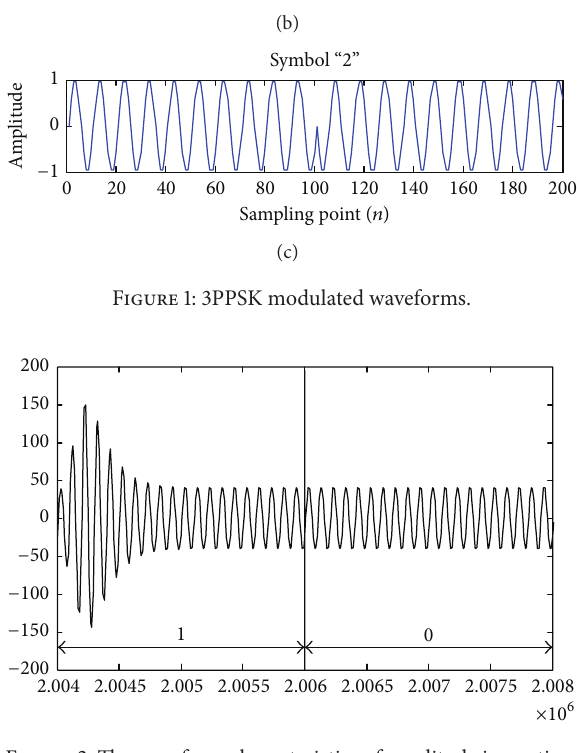
modulator 1 would stop transmitting CW in carrier frequency 𝑓 0 , and pulse train MPPSK modulator 2 transmits